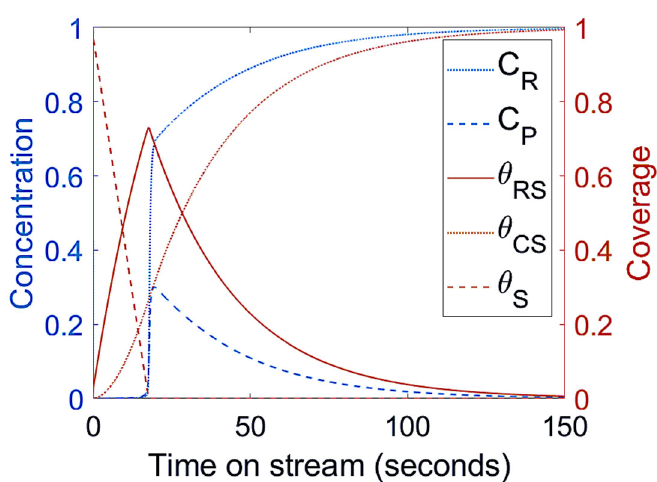
Figure 2. Estimated reactant and product concentration profiles ( left axis ) and surface species coverages ( right axis ) with respect to time for Mechanism II.